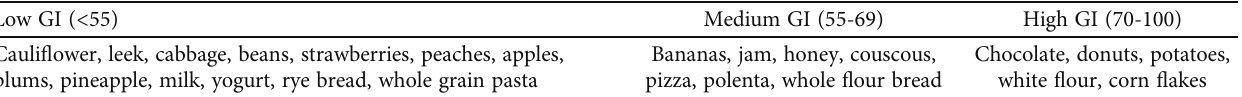
Table 4: Glycemic index of various foods — adapted after